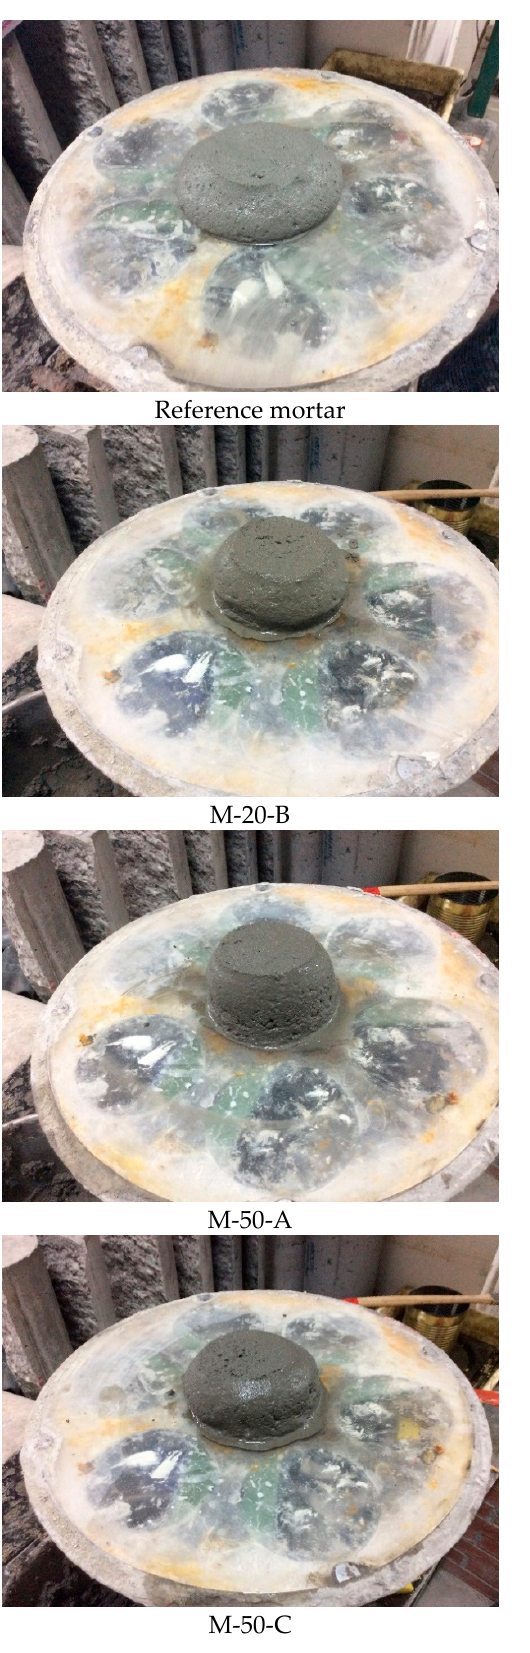
Figure 13. Fresh mortar workability.